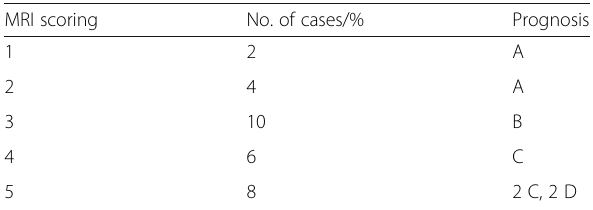
Table 4 Correlation between MRI scoring and prognosis in children with ANEC (WM, white